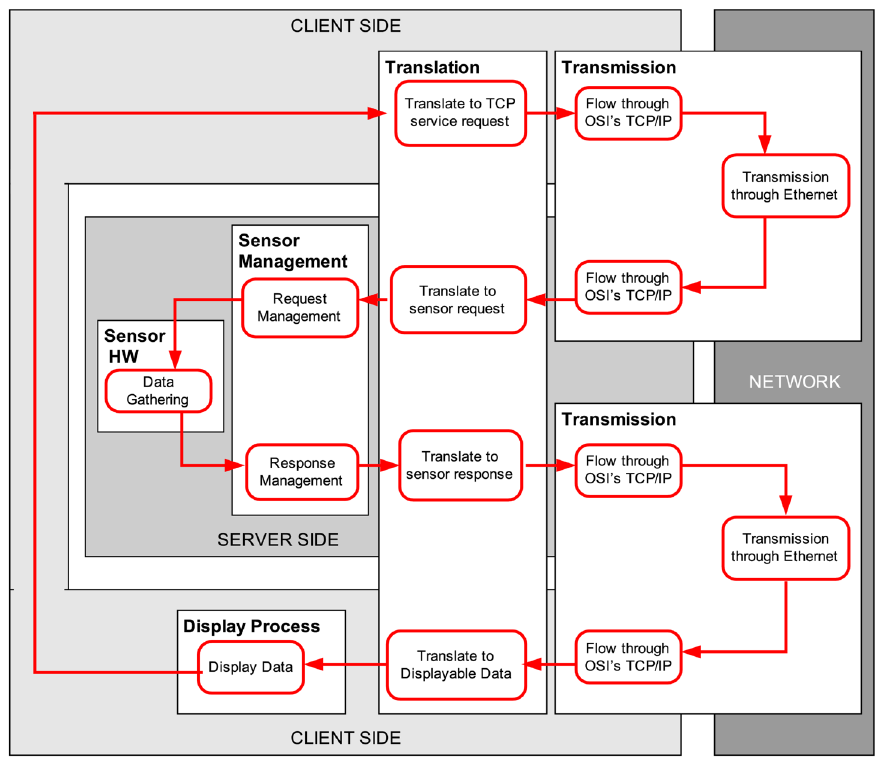
Figure 1. General scheme of a sensory loop in a networked telerobot controlled through the Internet, where both hardware and software components are non-deterministic in the real-time